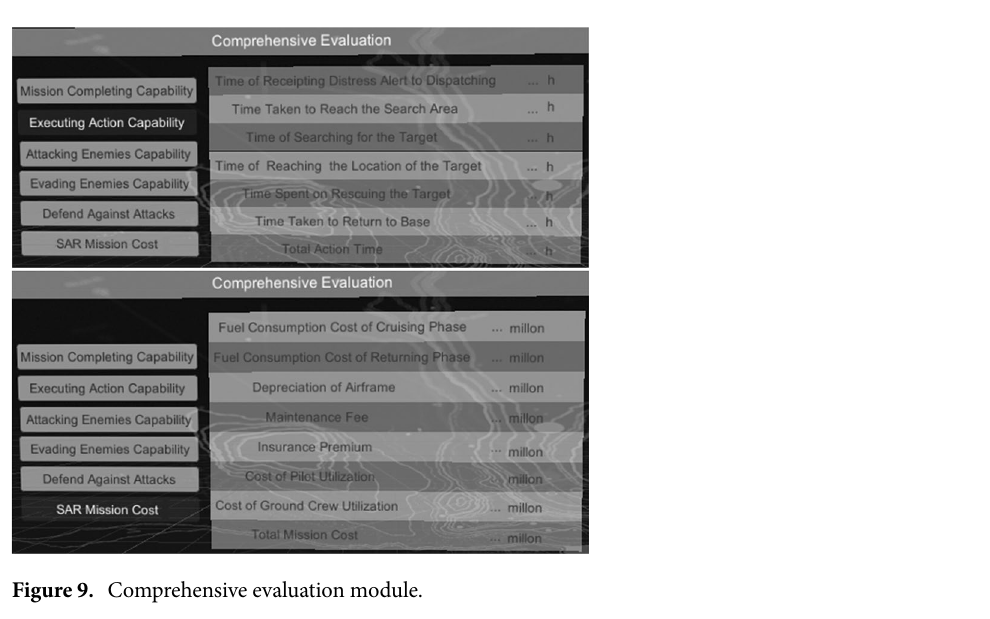
Fig. 1, keeping the affiliation relationships unchanged to complete the mapping conversion from the indicator decomposition hierarchy model to the evaluation analysis model. Specifically, the SAR SoS capability C SoS is decomposed into six sub-capabilities: C 1 , C 2 , C 3 , C 4 , C 5 , C 6 . Then the sub-capability is further decomposed to obtain the decomposition effect layer indicator C i , j and its indicator matrix, which is composed of the corresponding mission indicator X i . Based on the refined indicator analysis model, each layer of capability is analyzed in the subsequent analysis process according to the SPS analysis method to evaluate the influence degree of the aviation equipment on the SAR SoS. First, the range of the variation interval of each indicator X i in the indicator matrix in this experiment is determined, and the variation range of the values of nineteen indicators are shown in Tables 5 and 6. Then, X i is